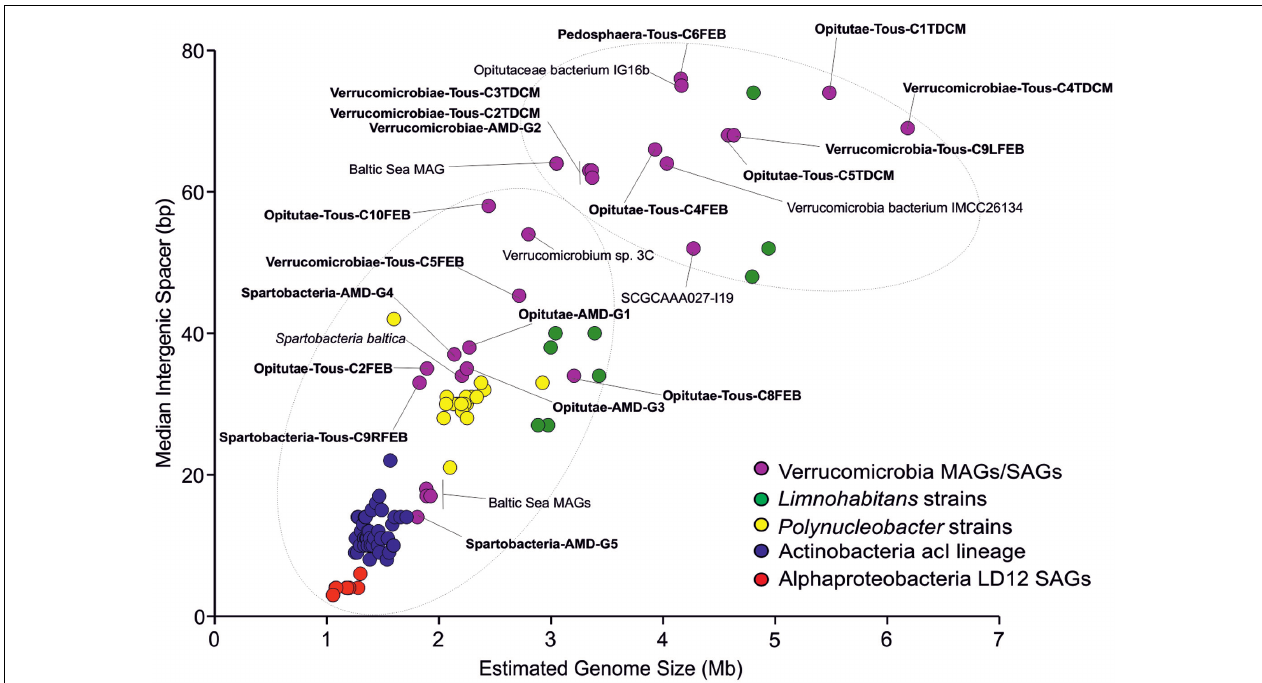
FIGURE 2 | Estimated genome size (Mb) versus median intergenic spacer (bp) scatter plot of Tous and Amadorio Verrucomicrobia MAGs compared to other freshwater microbes. We include all known brackish and freshwater Verrucomicrobia , representatives of the streamlined freshwater AcI lineage Actinobacteria (Ghai et al., 2014; Kang et al., 2017; Neuenschwander et al., 2017), freshwater Alphaproteobacteria LD12 SAGs (Zaremba-Niedzwiedzka et al., 2013), freshwater heterotrophic Limnohabitans strains and members of the cosmopolitan and abundant Polynucleobacter genus. Estimated genome sizes have been calculated based on checkM completenesses for each MAG, SAG, strain, or cultured genome. Tous and Amadorio MAGs are highlighted in